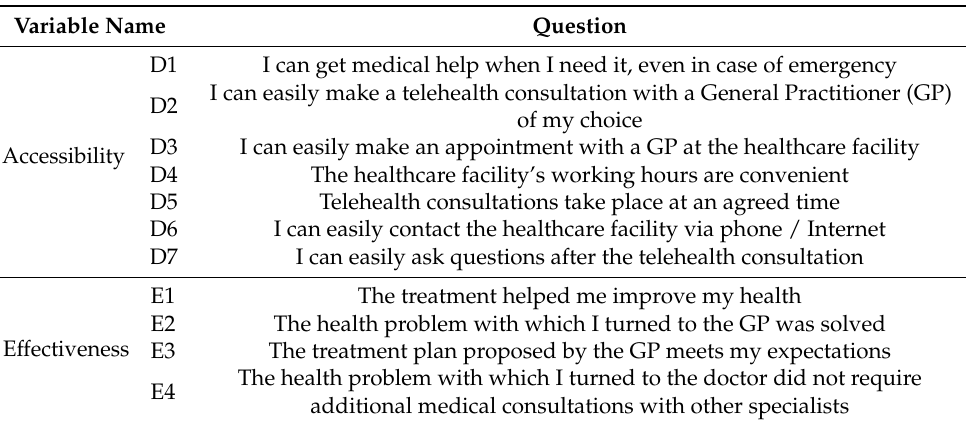
Table 2. Questions concerning the accessibility and treatment effectiveness dimensions initially included in the